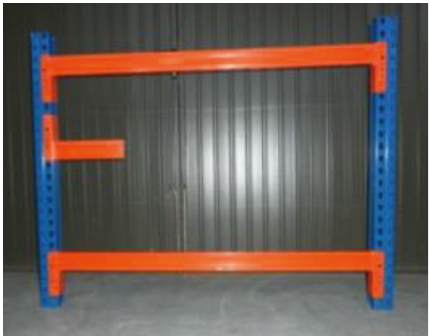
Figure 2: Structural flexibility with shelving systems.